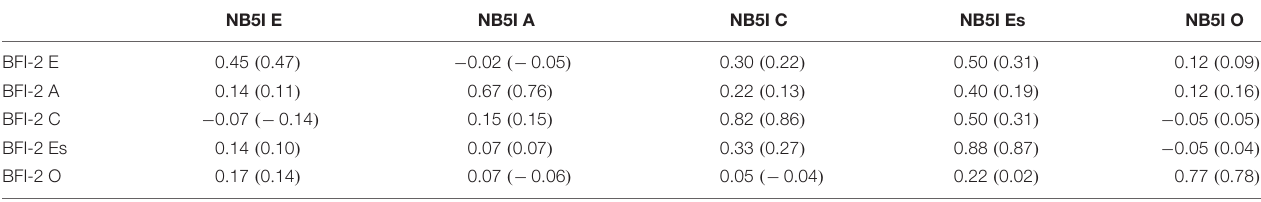
TABLE 4 | Convergent validity: univariate correlations between the factor scales of NB5I English and BFI-2, and partial correlations with control for evaluative factor.